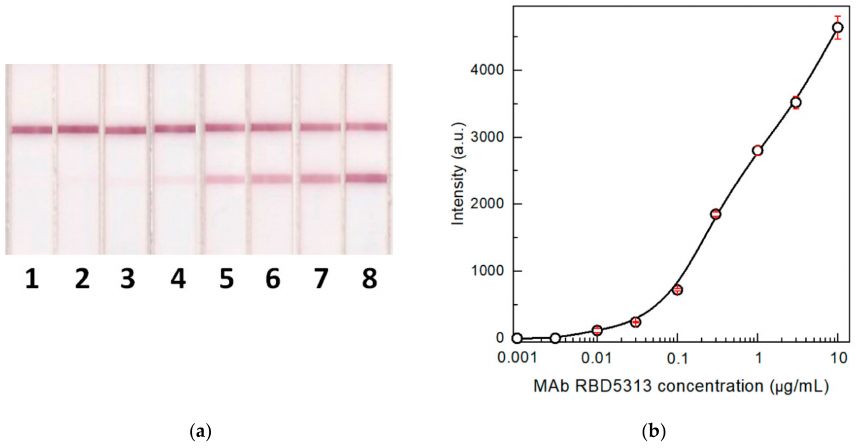
Figure 3. Images of test strips ( a ) after the common LFIA of samples containing 0.003 (1), 0.01 (2), 0.03 (3), 0.1 (4), 0.3 (5), 1 (6), 3 (7), and 10 (8) µ g/mL of MAb RBD5313 in PBS and the concentration dependence ( b ) of the assay ( n = 3). Hereafter, top and bottom colored lines on the images of test strips correspond to the CZ and TZ, respectively.